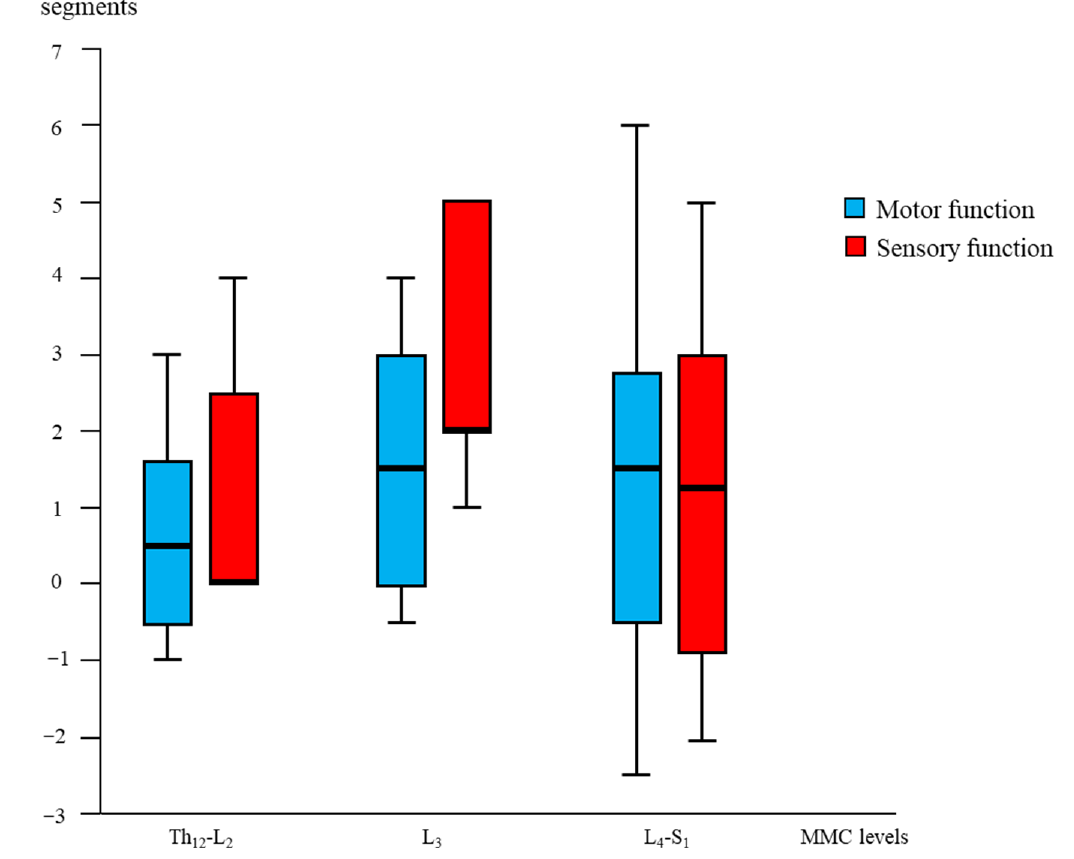
Figure 3. Segmental “gain” after fetal (OSBAR and FSBAR) intervention. Combined OSBAR- and FSBAR- data are provided from the perspective of the lesion-matched NSBAR group. The x -axis indicates the segmental MMC levels of the included age- and lesion-matched children. The y -axis indicates the segmental difference between fetal versus neonatal intervention. Red bars indicate sensory function, and blue bars indicate motor function. Positive values indicate the number of gained segments after fetal versus neonatal intervention. Box plots mark the first and third quartiles; whiskers represent data points 1.5 times the interquartile range below and above the first and third quartiles. Fetal intervention at L3-L4 lesions seemed most favorable. Abbreviations: MMC = myelomeningocele; fSBA = the total group of fetal interventions (OSBAR + FSBAR); NSBAR-total = the total group of neonatal interventions (age- and lesion-matched with fSBA).